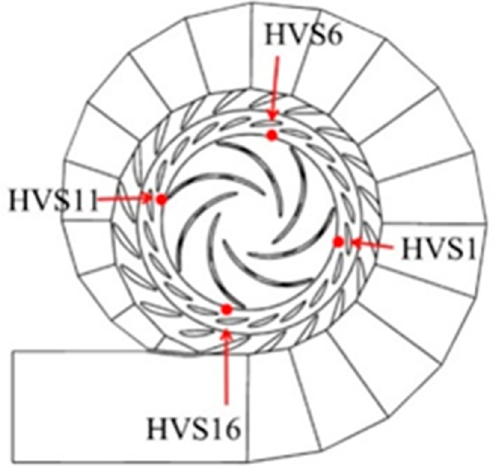
Figure 4. Pressure monitoring points in circumferential direction in the vaneless space.